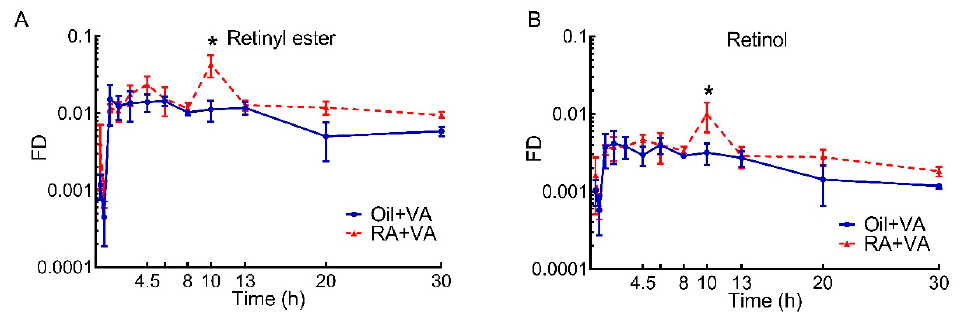
Figure 5. Fraction of ingested dose (FD) present as retinyl ester and retinol vs. time after administration of 3 H-labeled VA supplement in neonatal rats: ( A ) RE; ( B ) Retinol. Data are presented as means ± SEM, n = 4–6 pups/time/group. * indicates statistically significant difference between groups, p < 0.05. Table 5. 3 H-labeled VA present as RE and retinol in neonatal intestine after VA supplementation. Area under the Curve Selected Time Interval,